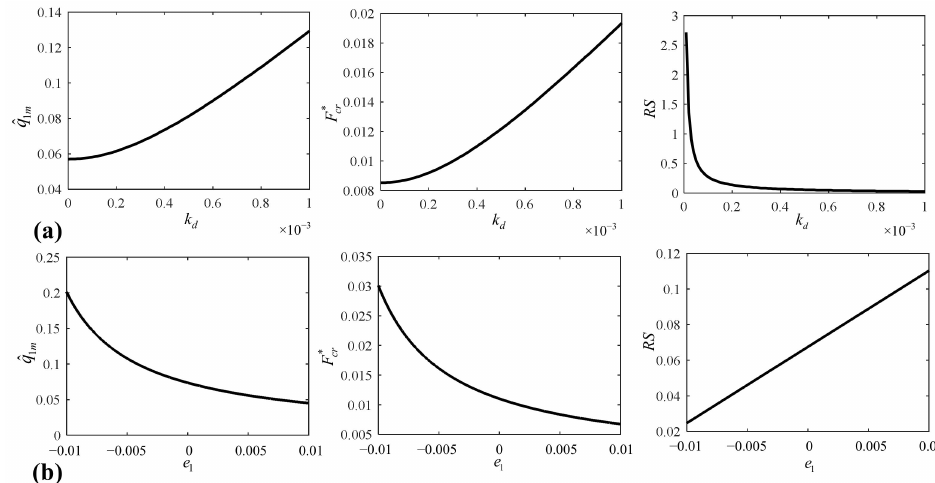
Figure 8. Three indexes affected by ( a ) k d and ( b ) e 1 ( σ 1 = 0, σ 2 =